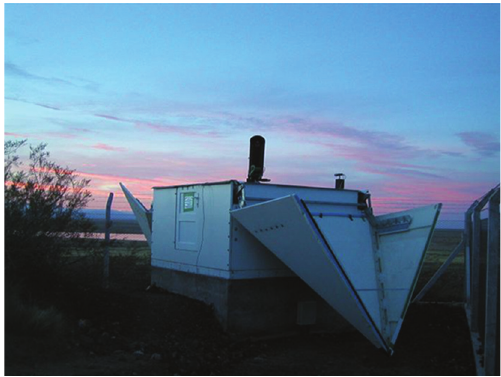
Figure 1: Original configuration FRAM telescope and its enclosure during sunset at the Los Leones site.